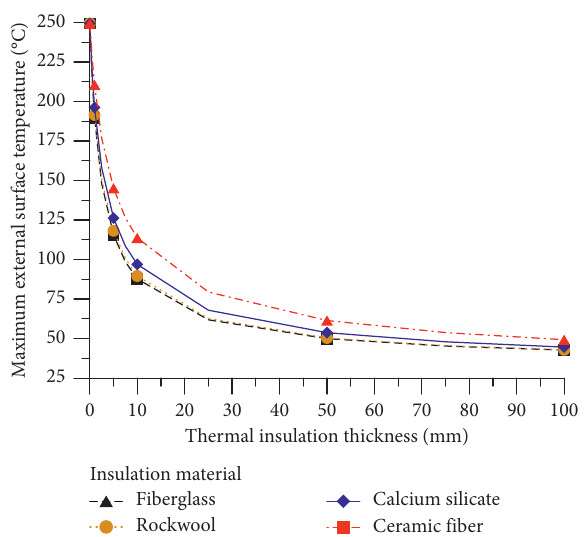
Figure 17: Maximum external surface temperature as a function of thermal insulation